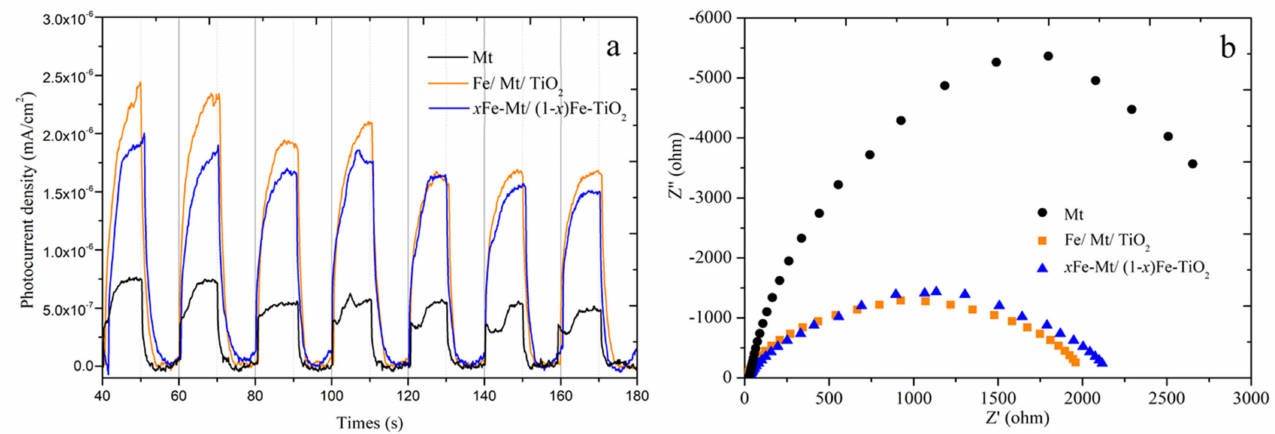
Figure 8. ( a ) Photocurrent density versus time measurements of Mt, Fe/Mt/TiO 2 , and x Fe-Mt/(1 − x )Fe-TiO 2 synthesized at 70 ◦ C under 0 V versus Ag/AgCl bias; ( b ) Nyquist plots of the EIS spectra of Mt, Fe/Mt/TiO 2 , and x Fe-Mt/(1 − x )Fe-TiO 2 synthesized at 70 ◦